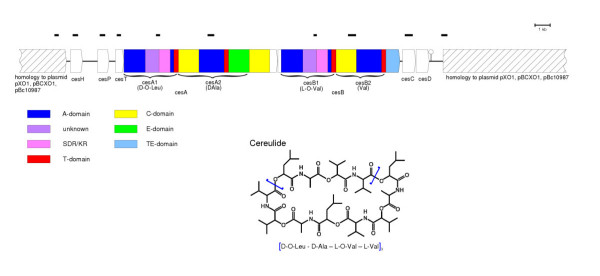
Biosynthetic gene cluster for cereulide synthesis. The domain organization of the structural cereulide synthetase genes cesA and cesB is indicated (see Results for details) and the flanking regions showing homologies to toxin plasmids from B. cereus group members are printed as hatched boxes. For details on CDS designation see Table 2. The bars refer to probes used to test the conservation of ces genes in the B. cereus group (see Table 3) Inset: Structure of cereulide according to [13].